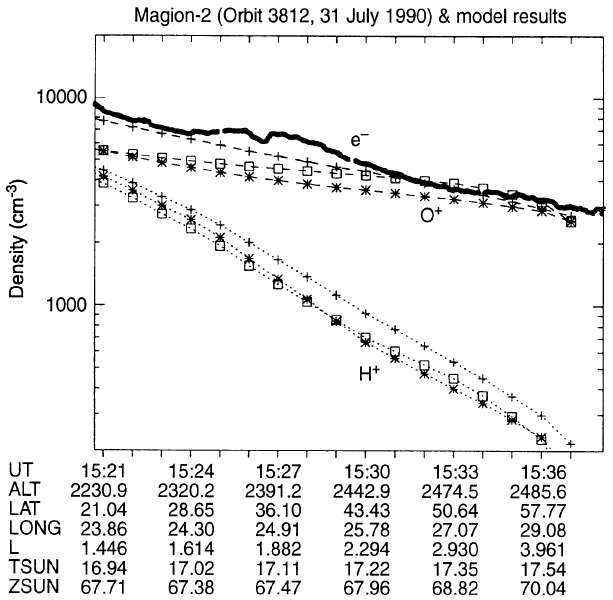
Fig. 10. As in Fig. 5, for comparison of model results with measured electron density values obtained on-board Magion-2 (Langmuir probe) along the satellite orbit 3812. The effect of vibrationally excited N * (cid:50) is investigated: without N * (cid:50) ( curves with crosses ), assum- ing „ (cid:118) " 1.25 „ (cid:110) ( asterisks ) and „ (cid:118) " 1.5 „ (cid:110) ( squares